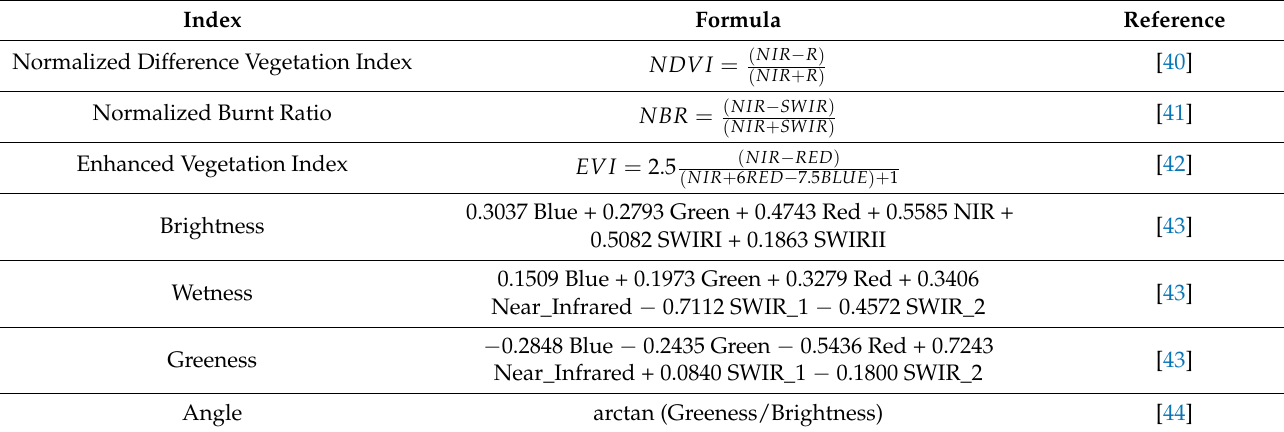
Table 1. Predictor variables for the time series